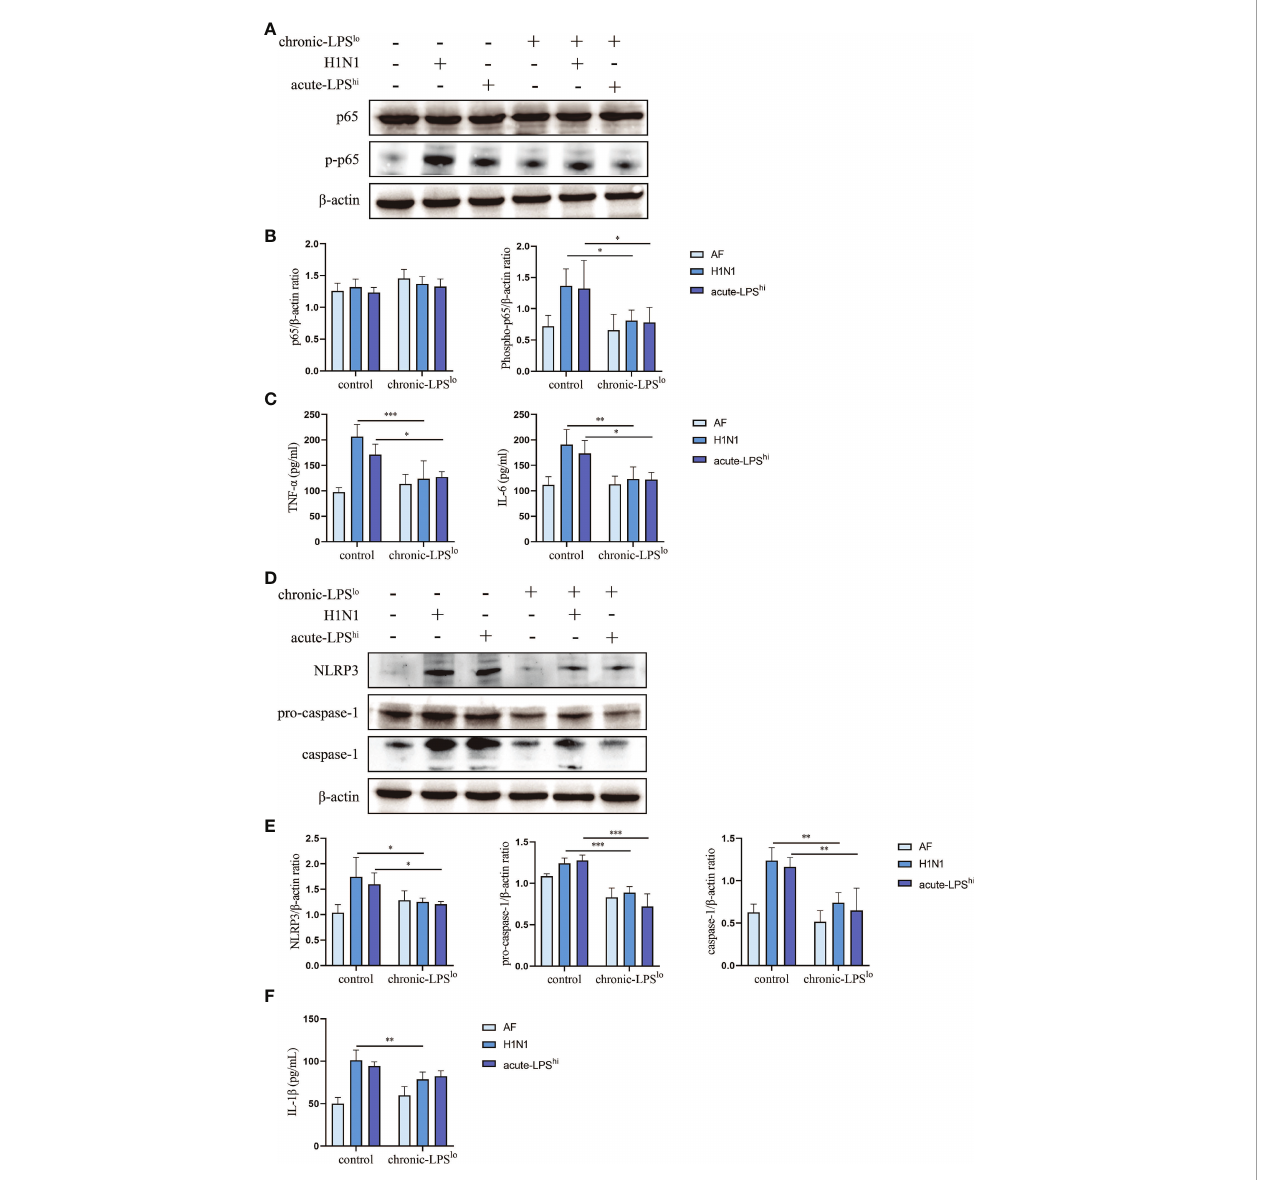
FIGURE 2 Effect of chronic low-dose LPS stimulation on NF- k B signaling pathway and NLRP3 in fl ammasome in high dose LPS-stimulated or H1N1-infected mice. (A, B) Relative protein levels of p65 and p-p65 in lung tissues were detected by western blot. (C) TNF- a and IL-6 in mice sera were measured by ELISA. (D, E) Relative protein levels of NLRP3, pro-caspase-1 and caspase-1 in lung tissues were detected by western blot. (F) IL-1 b in mice sera were detected by ELISA. Data are mean ± SD, n = 3. *p< 0.05, **p< 0.01, ***p<